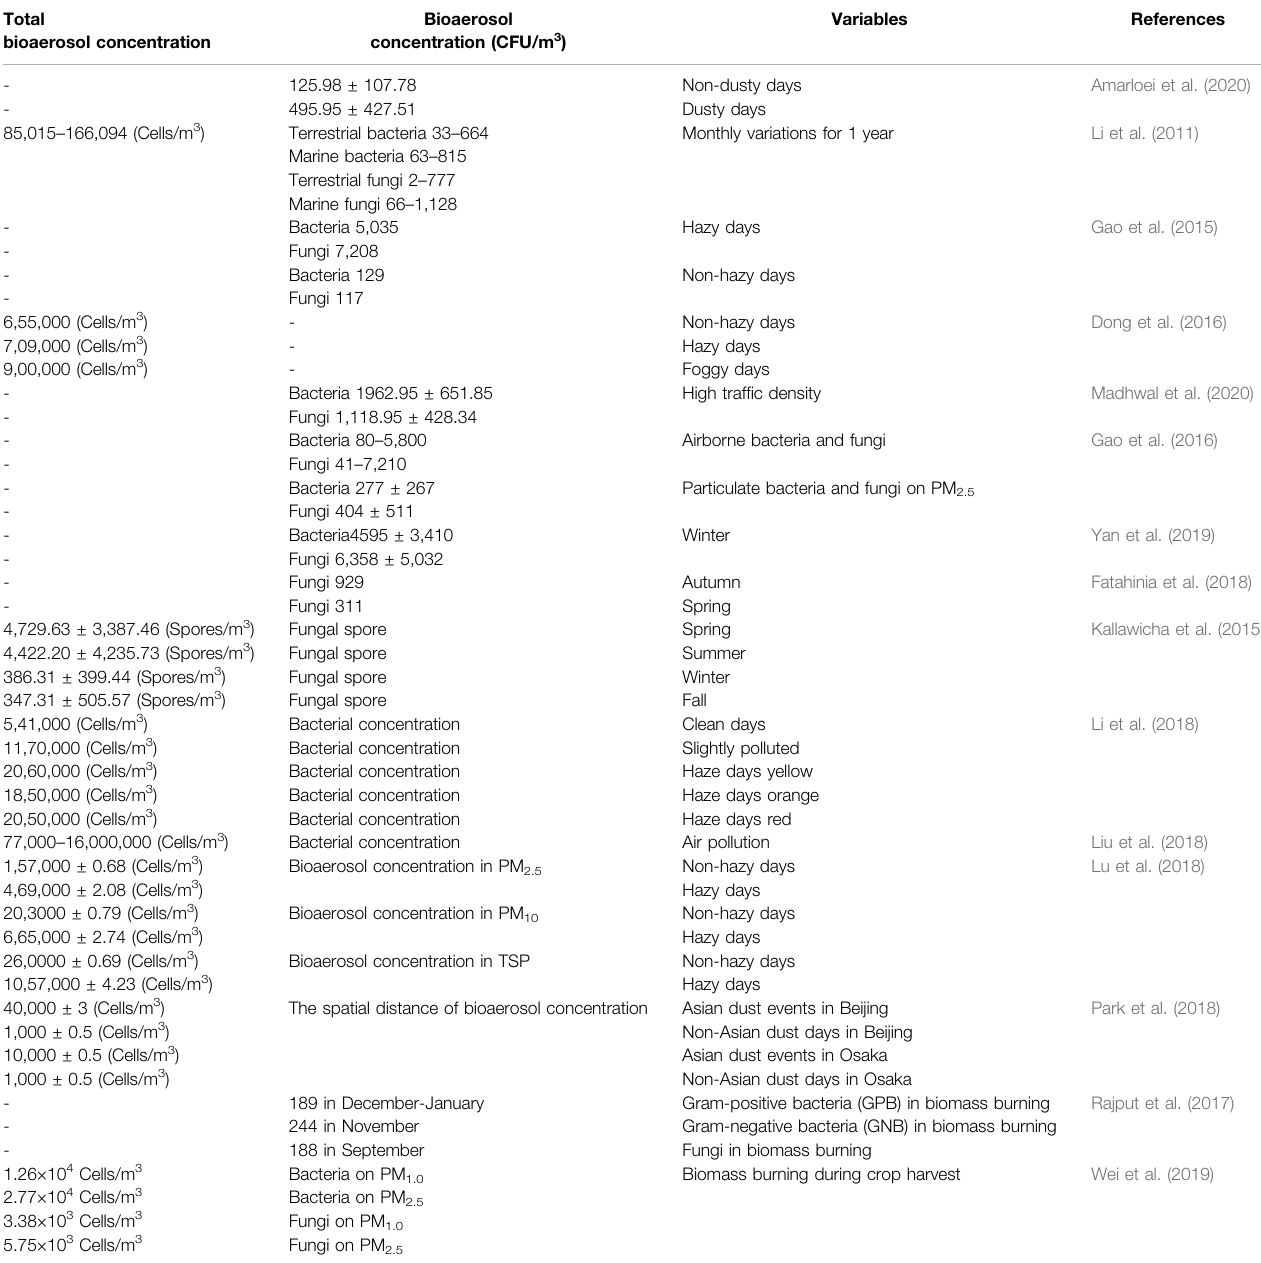
TABLE 3 | Bioaerosol concentration reported from different studies with the reported